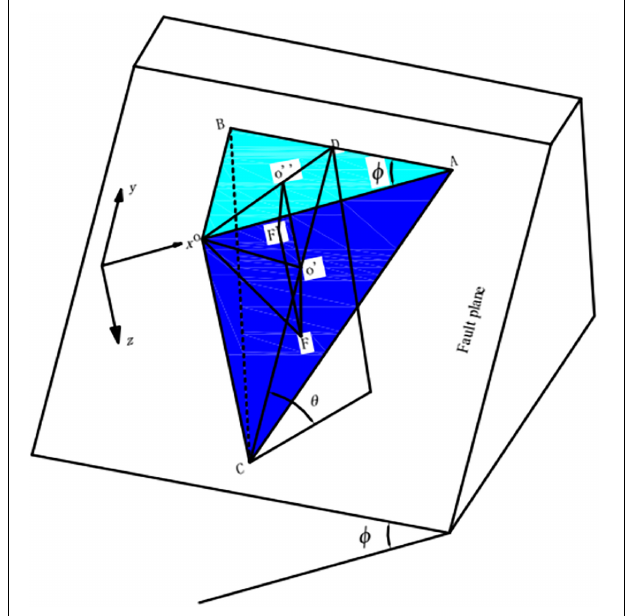
FIGURE 1 | Corresponding relationship between fault occurrence and principal stress direction. OA is the direction of maximum principal stress, OB is the direction of minimum principal stress, OC is the direction of vertical stress, of is the direction of resultant stress of OA and OB and OC acting on surface ABC, OO (cid:48) is the direction of normal resultant stress of three-dimensional stress acting on fault surface, O (cid:48) F is the direction of tangential resultant stress of three-dimensional stress acting on fault surface, and O (cid:48)(cid:48) F (cid:48) is the projection direction of O (cid:48) F on the horizontal plane. The angle between the strike and horizontal principal stress direction of the fault slope is ϕ and the dip angle is θ ; the maximum and minimum horizontal principal stress and vertical stress are σ H , σ h , and σ v , respectively, and plane ABC is the unit plane on the fault